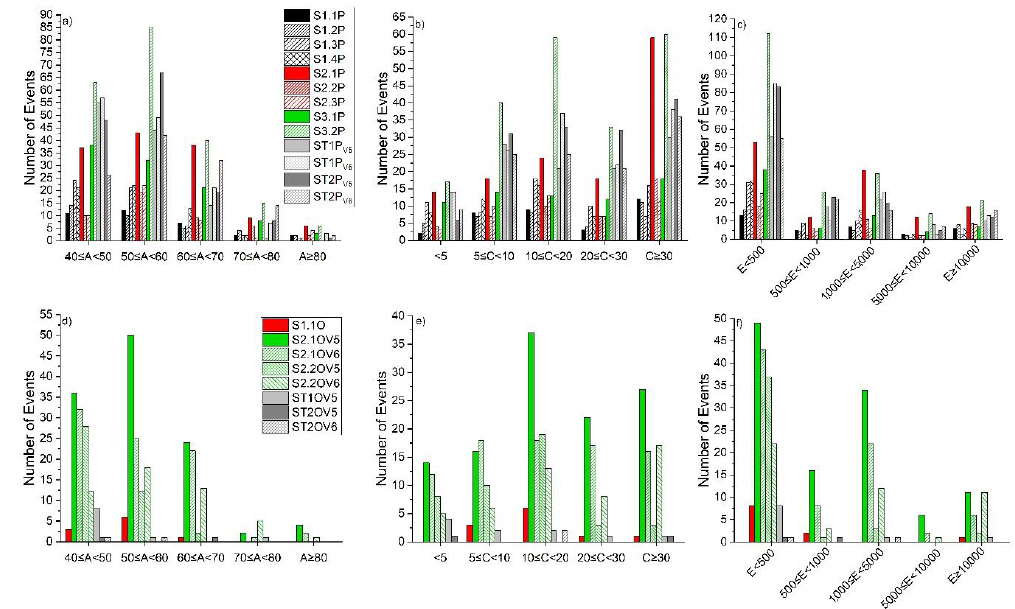
Figure 6. Distribution of AE parameters in the brittle-like (BL) state intervals. ( a ) Amplitude, pine; ( b ) Counts, pine; ( c ) Energy, pine; ( d ) Amplitude, oak; ( e ) Counts oak; ( f ) Energy, oak.